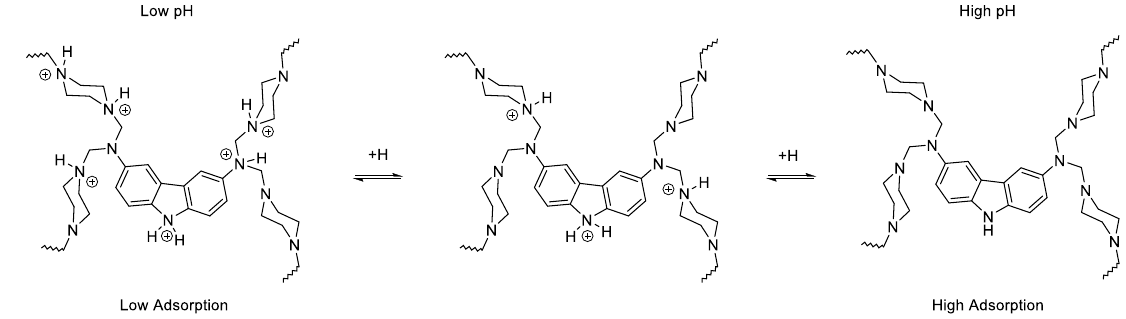
Scheme 2. Effect of pH on the protonation of MXM the